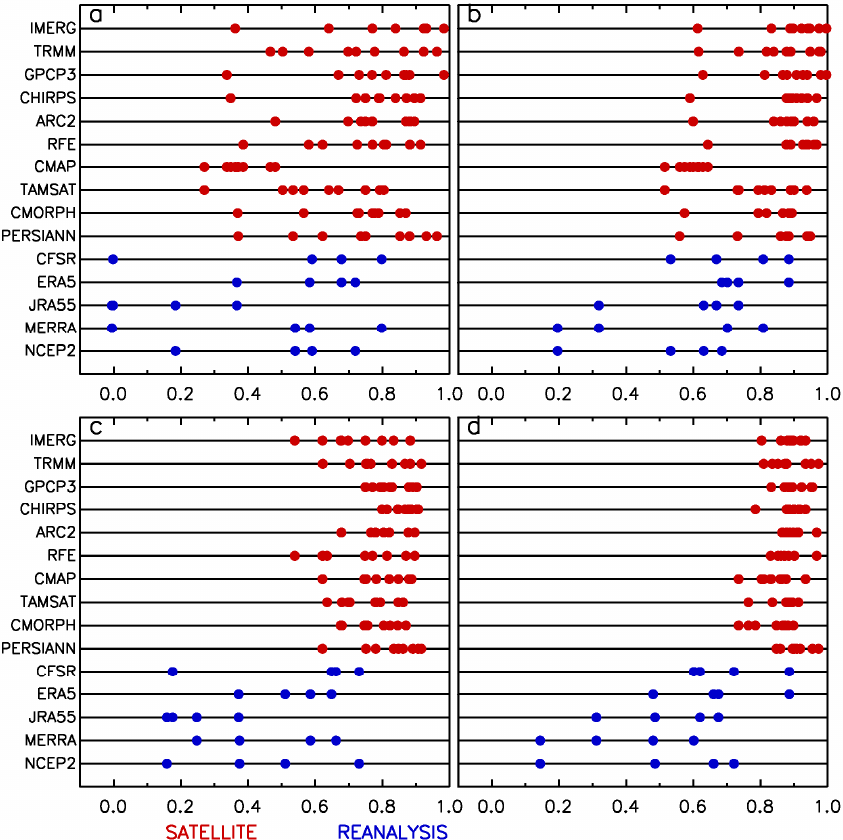
Figure 16. Correlation among rainfall products in the Lake Victoria region. Each satellite product is correlated with all other satellite products, with the correlation values indicated on the horizonal axis (red values). Each reanalysis rainfall product is correlated with every other reanalysis product (blue values). Annual rainfall correlations are on the left. November correlations are on the right. Top panels ( a , b ) are for rainfall over the catchment and bottom panels ( c , d ) are for rainfall over the lake. The 10% significance level is 0.37 and the 5% significance level is